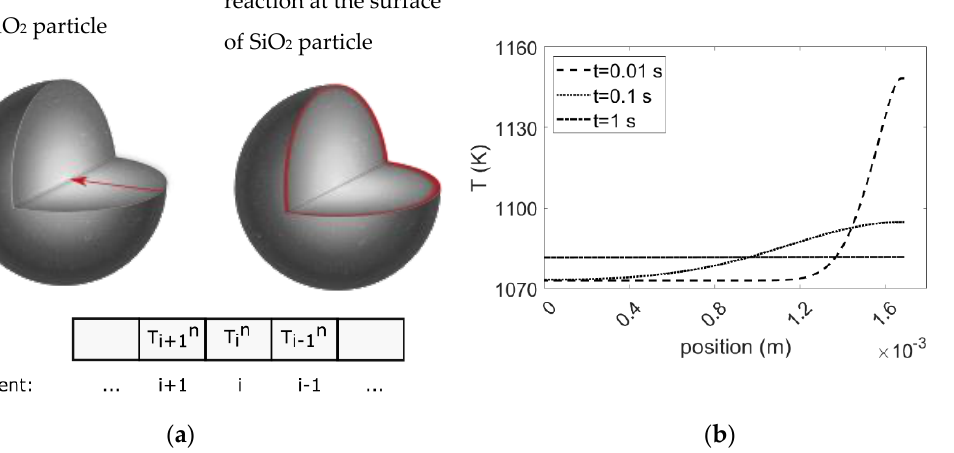
Figure 10. ( a ) Schematic illustration of heat transfer through a particle radius. ( b ) Temperature profile after reduction of first element at a Mg/SiO 2 mole ratio of 4 and 1073 K.